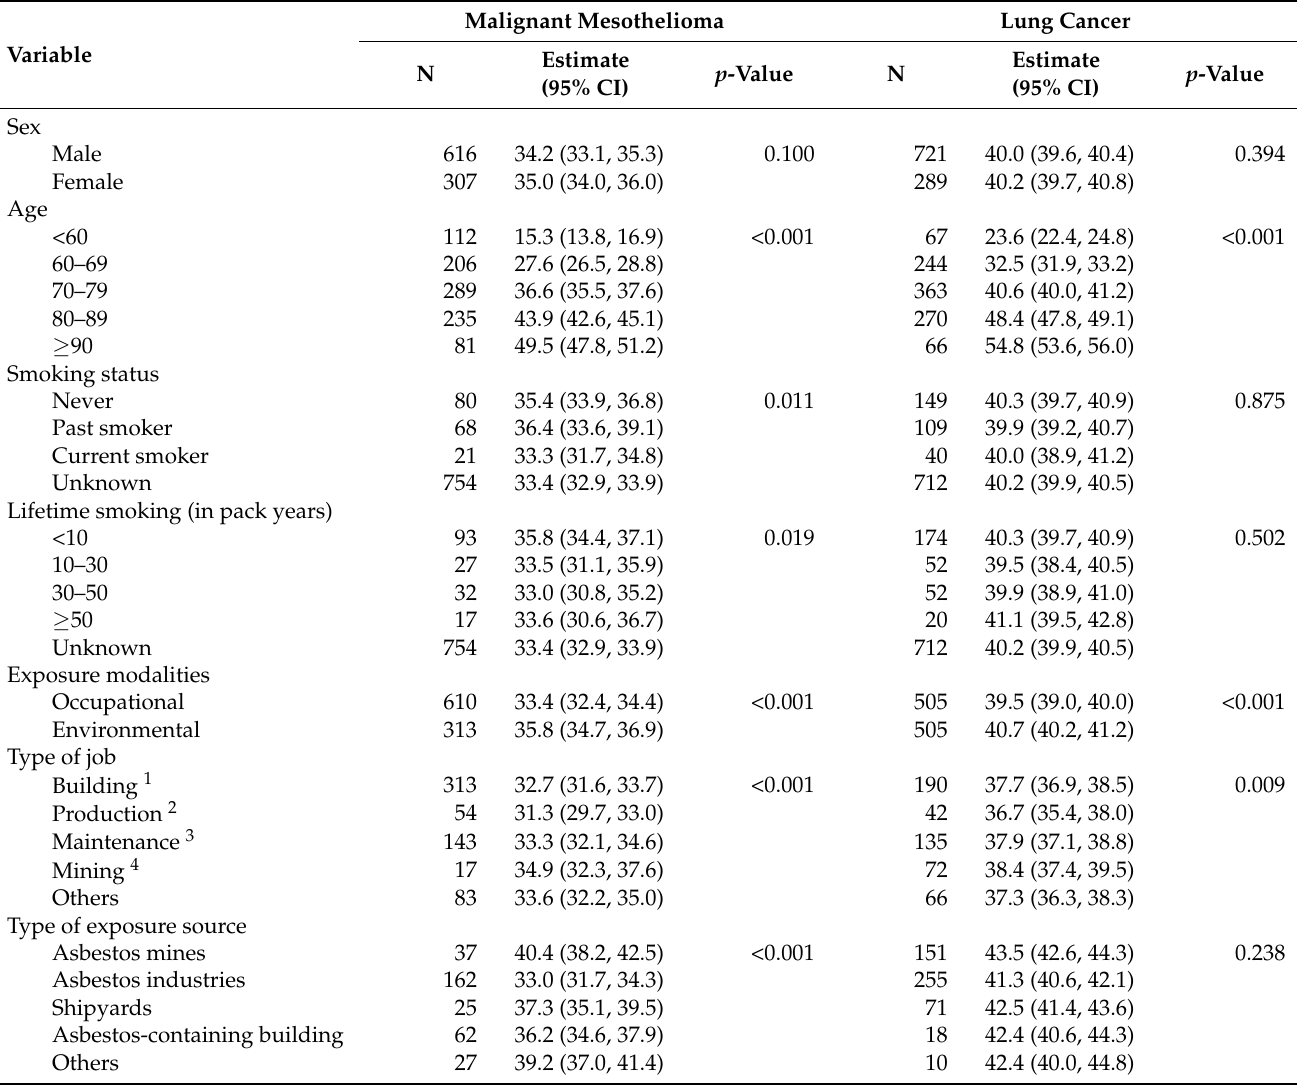
Table 3. Adjusted mean latency periods according to characteristics of the